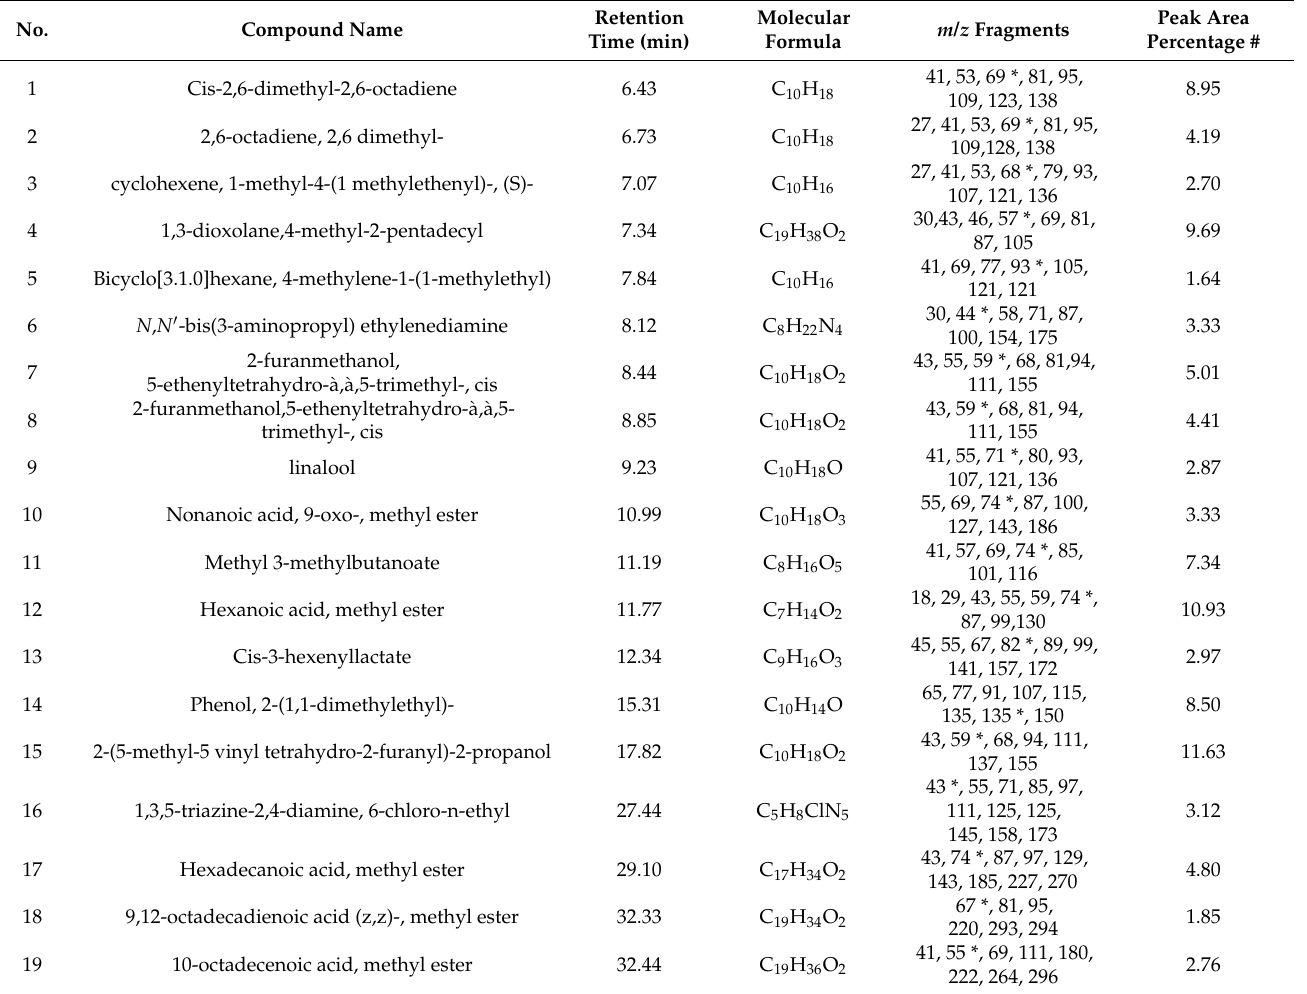
Table 8. Volatiles composition of methanolic extract of Solenostemma argel .